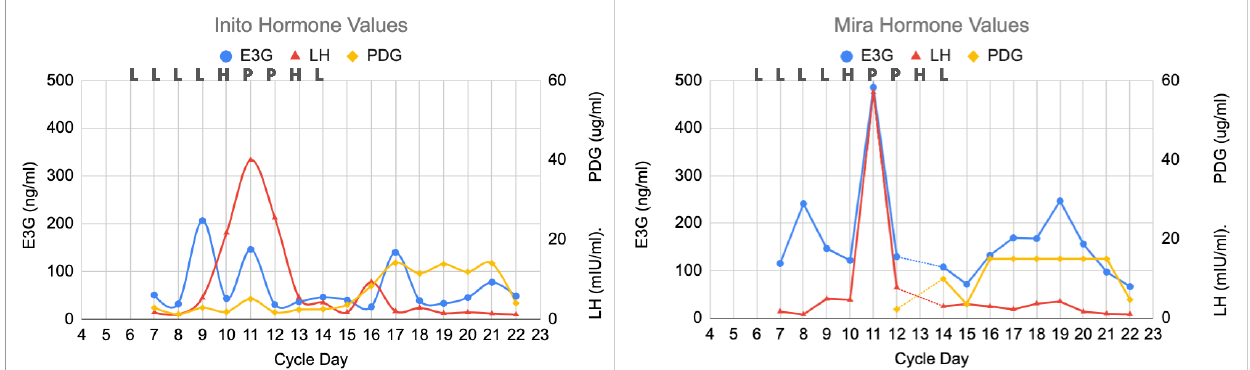
Figure 1. Normal cycle showing all three monitors with agreement on the peak day, with the highest LH value on that day (cycle day 11). The ClearBlue results (L = Low, H = High, and P = Peak) are shown above each graph on the respective days. The estimated day of ovulation was day 12 (day after LH peak). The luteal phase was 13 days (cycle length of 25 days). PDG initially rose on day 16 on the Inito monitor and on day 14 on the Mira monitor.